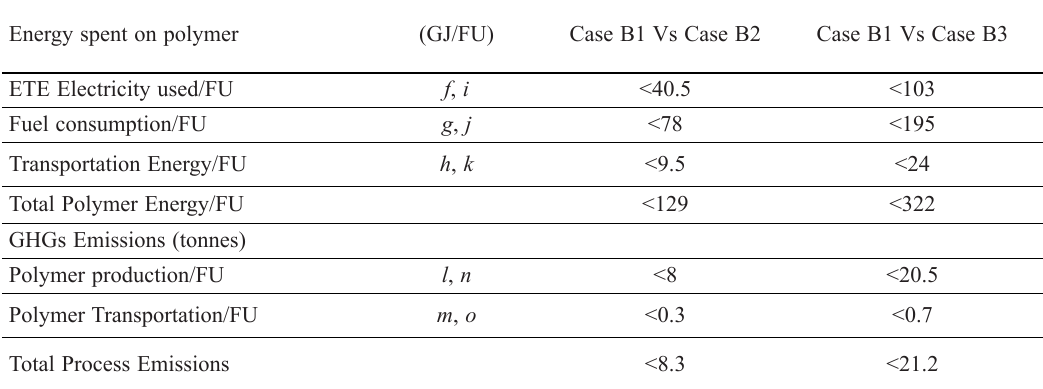
Table 7. Beneficial bitumen modification boundaries w.r.t. energy and emissions allocation for Case study B Energy spent on